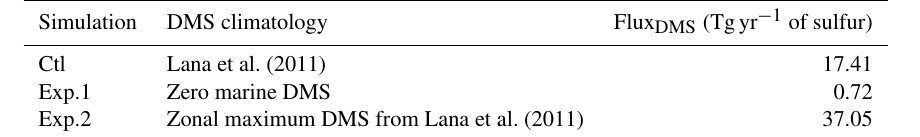
Table 1. Summary of the three global simulations presented in this study, the DMS w climatology used and the annual mean (2000–2009) total global flux DMS .